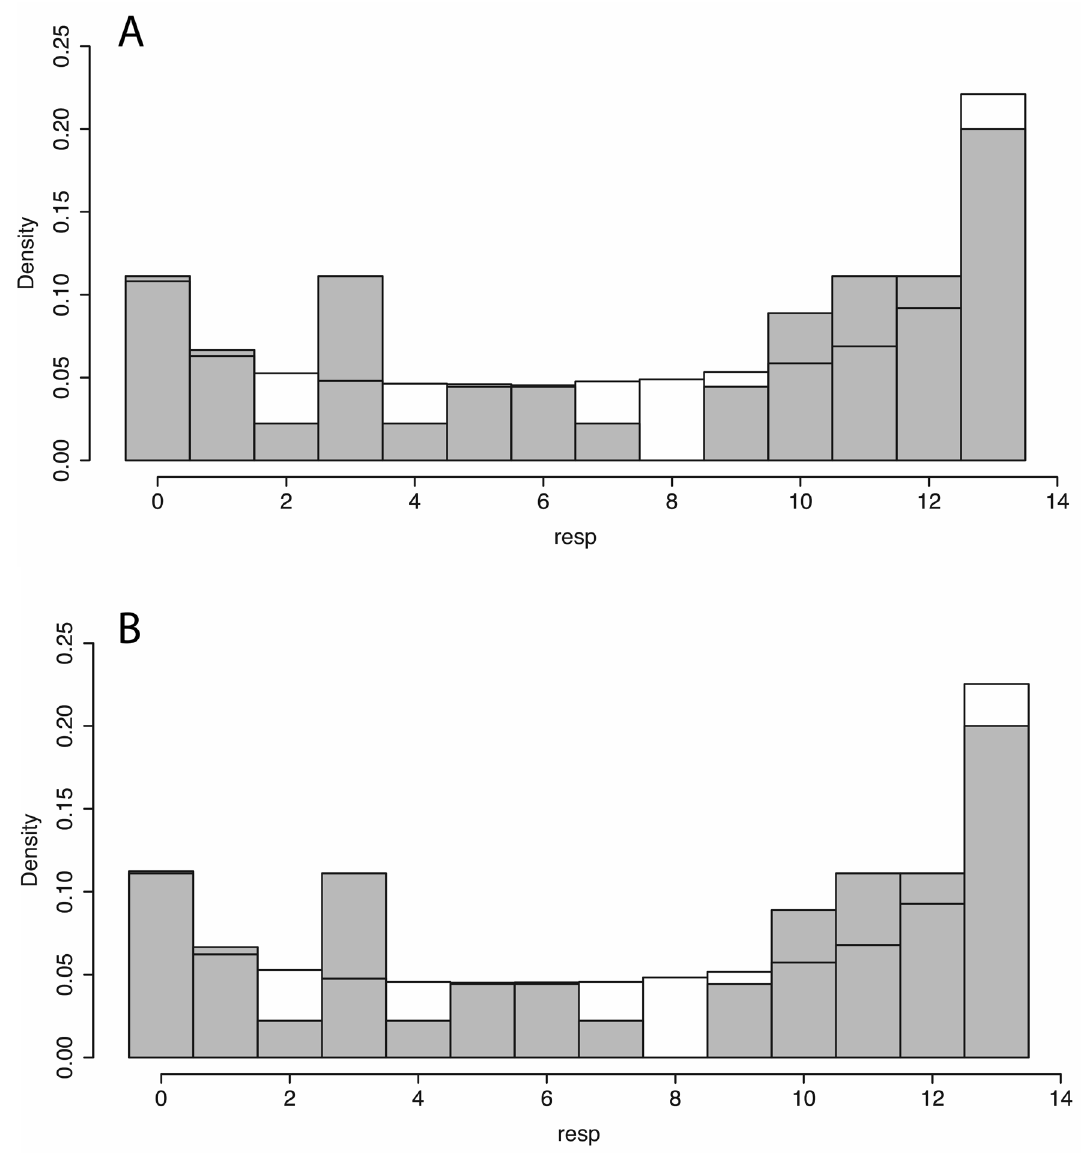
Figure 4. Histogram of the observed values of resp (in grey) overlaid with the histograms from the predicted posterior distributions (shown in white). ( A ) For the model with proprandom as the independent variable (Eq. 3). ( B ) For the model with RLLevel as the independent factor (Eq.